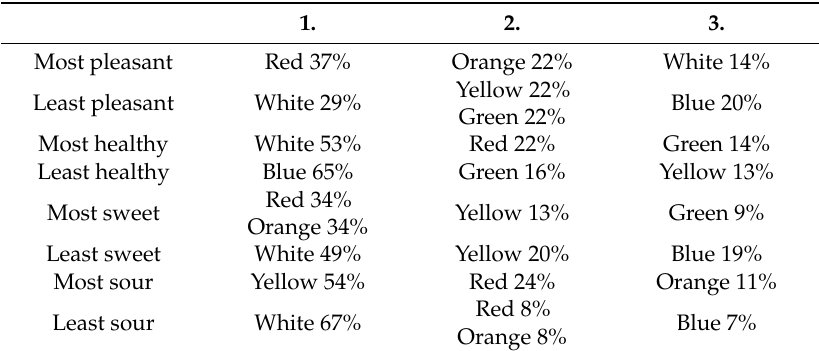
Table 2. Three most frequently (columns 1., 2., 3.) selected color samples as the most or the least pleasant, healthy, sweet and sour (% of